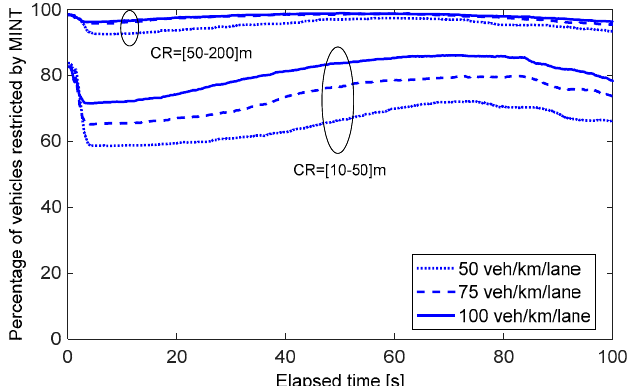
Figure 10. Time evolution of the percentage of vehicles with a required minimum transmission power established by the awareness control protocol MINT. The results are obtained with COMPASS coordinating the operation of A-DCC, MINT and TOWER. The results are depicted for different traffic densities and two possible intervals of the communication range (CR) requirements: between 50–200 m and between 10–50 m.